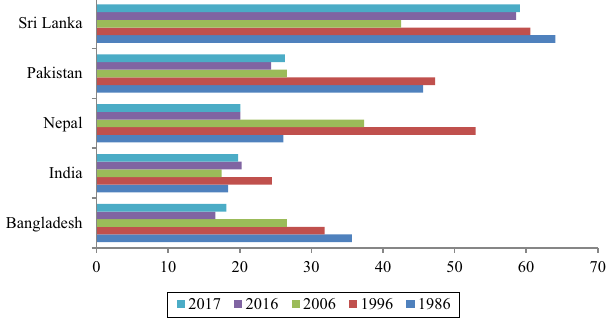
Figure 1. External debt